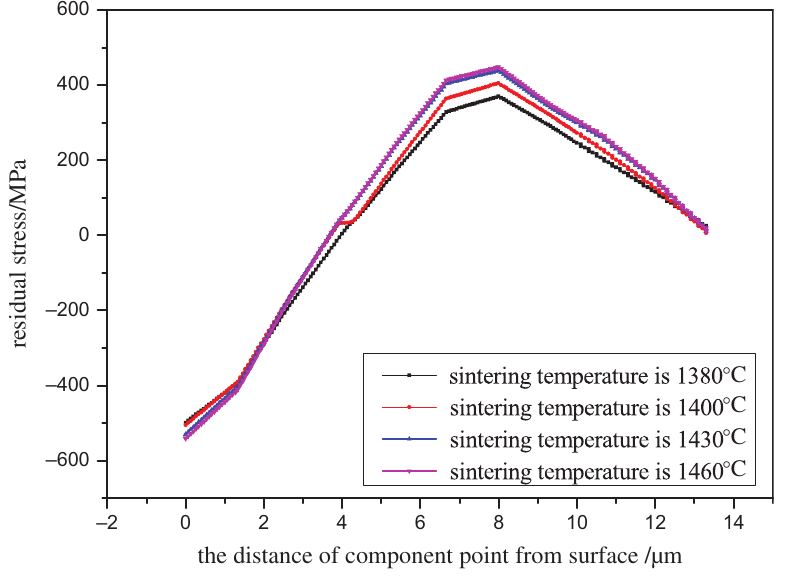
Figure 7: The effect of sintering temperature on residual stress in gradient